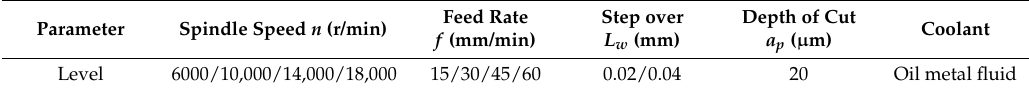
Table 1. Experimental cutting